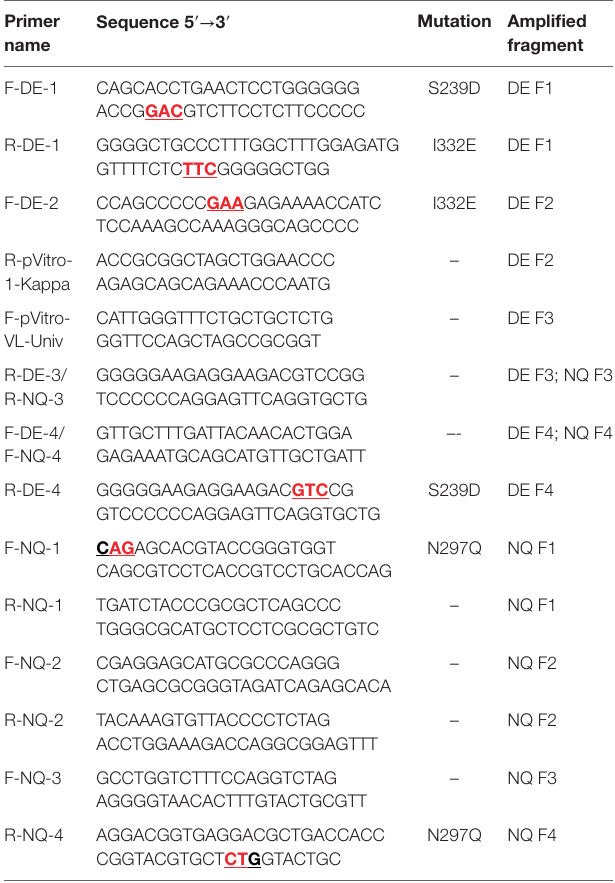
Table 1 | PCR primers for generation of anti-HER2 and anti–CSPG4 Fc mutant antibodies.